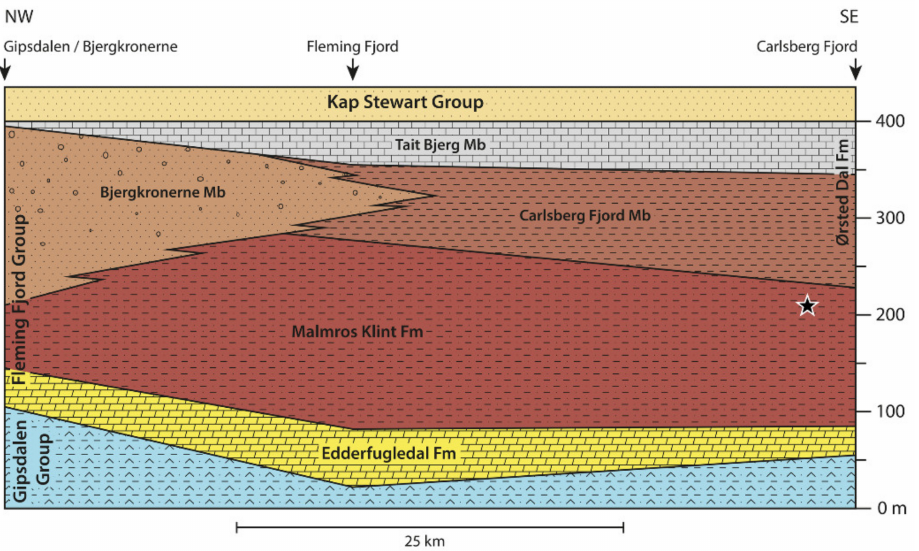
Figure 2. Cross-section of the lithostratigraphic units in the Fleming Fjord Group. Schematic cross- section of the lithostratigraphic units in the Fleming Fjord Group, Jameson Land. The star marks the uppermost Macknight Bjerg site where the sauropodomorph specimens were collected. Modified from